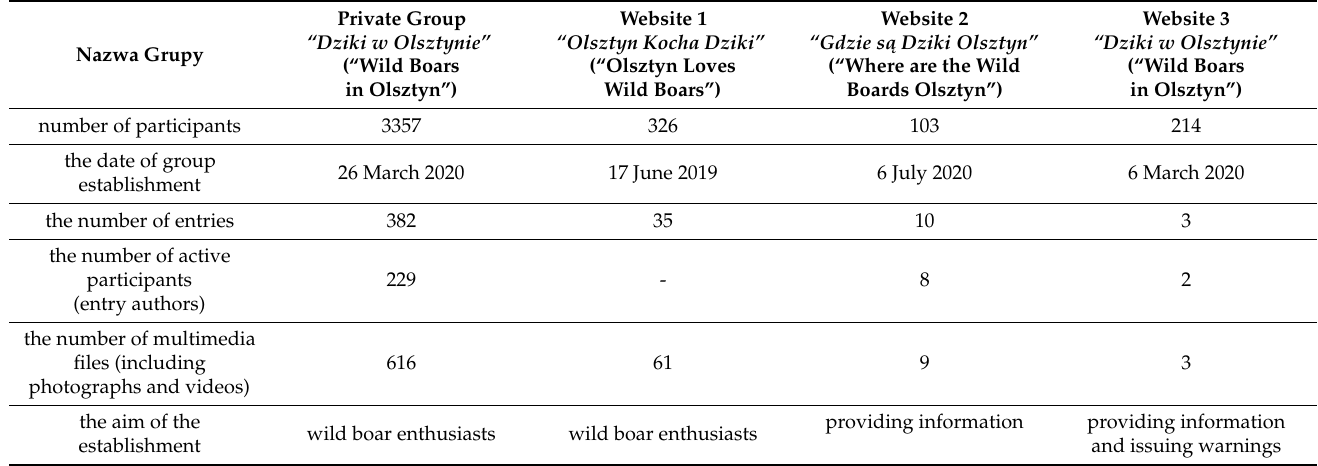
Table 3. Crowdsourced data on wild boars in